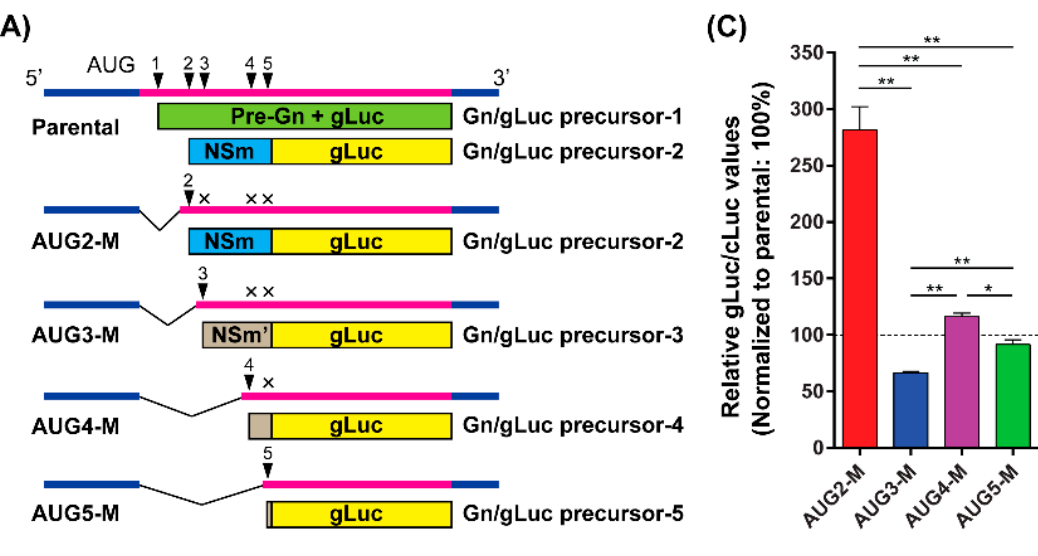
Figure 3. Cont. Figure 3. Cont.